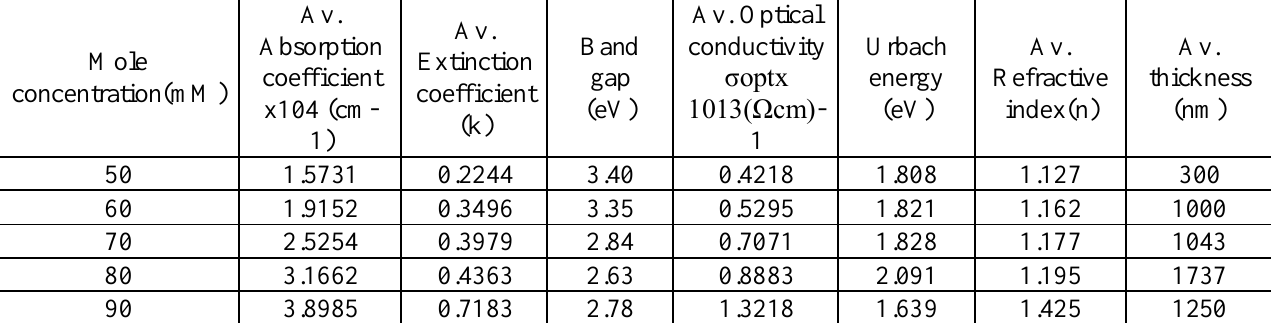
Table 1: Optical parameters of WO3 thin film deposited at various mole concentrations. Mole